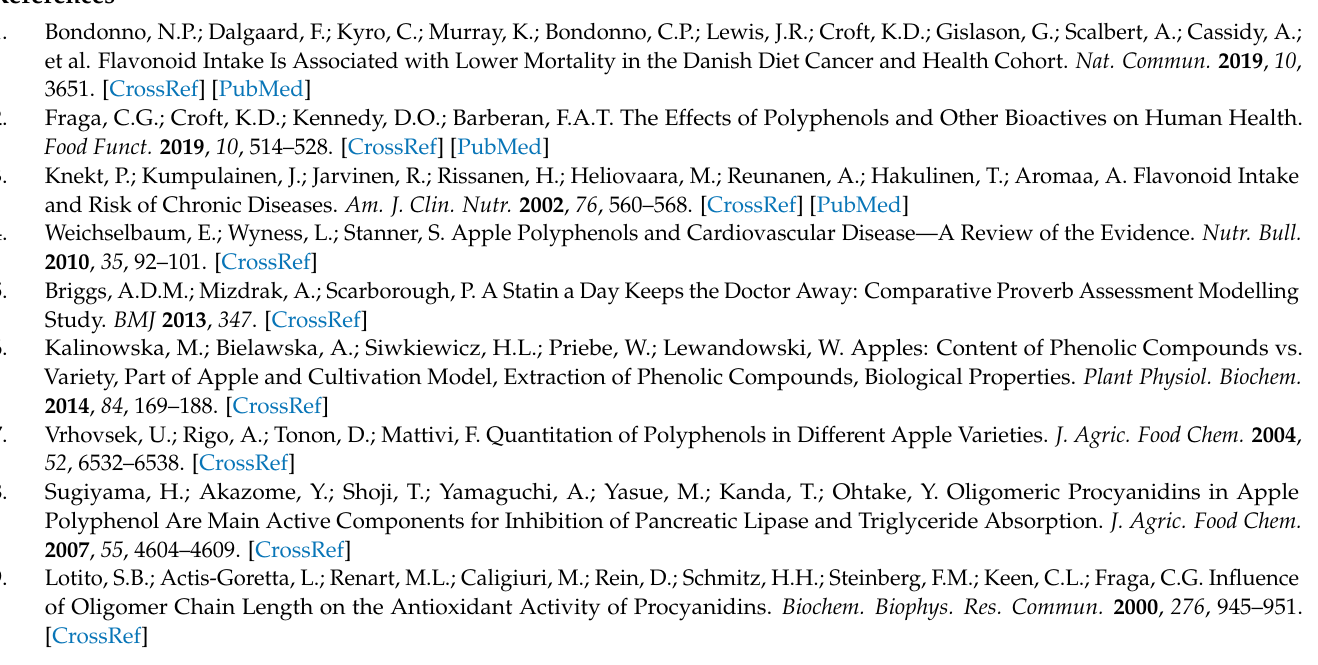
Chromatograms of each individual standards and apple extract by the rapid method. Figure S3: The correlations between apple soluble solid and flavan-3-ols and procyanidins concentrations in unbagged ‘Fuji’ apples. Figure S4: The correlations between apple soluble solid and flavan-3-ols and procyanidins concentrations in bagged ‘Fuji’ apples. Figure S5: The correlations between apple soluble solid and flavan-3-ols and procyanidins concentrations in unbagged ‘Orin’ apples. Figure S6: Comparison of the (A) flavan-3-ols and (B) procyanidins in the ‘Fuji’ apples with and without bagging during the 2016 and 2017